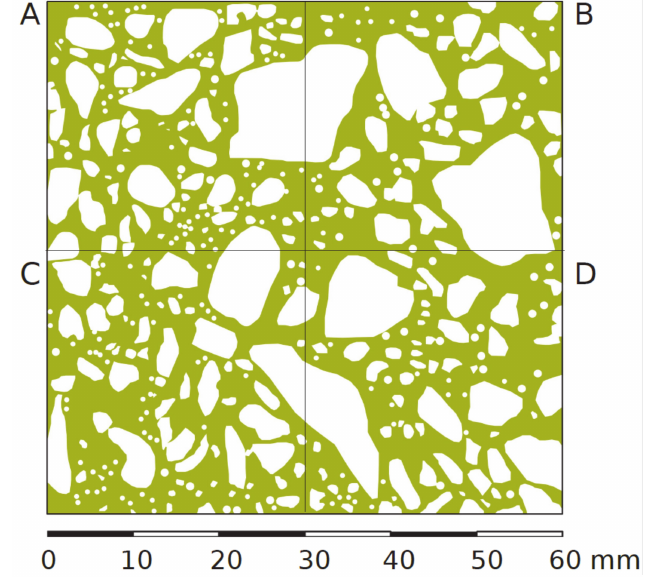
Figure 5. The 2D model of the concrete surface presented in Figure 3 (green—acement matrix, white—aggregates). ( A – D ): four segments of the